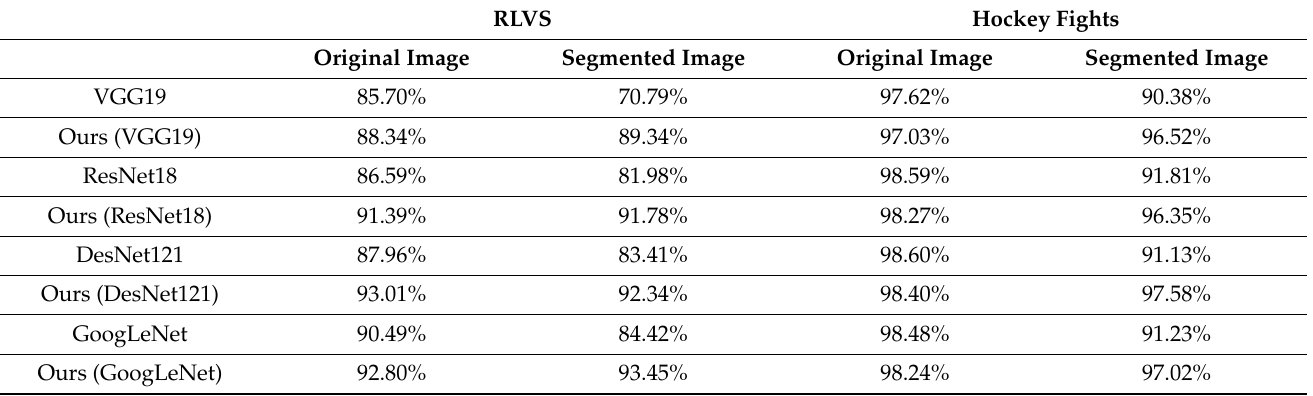
Figure 9. Changes in recognition rate during training. ( a ) VGG19, ( b ) GoogLeNet, ( c ) ResNet18, ( d ) DesNet121. Table 2. Comparative experiment grouping . Table 3. The effect of our method on different